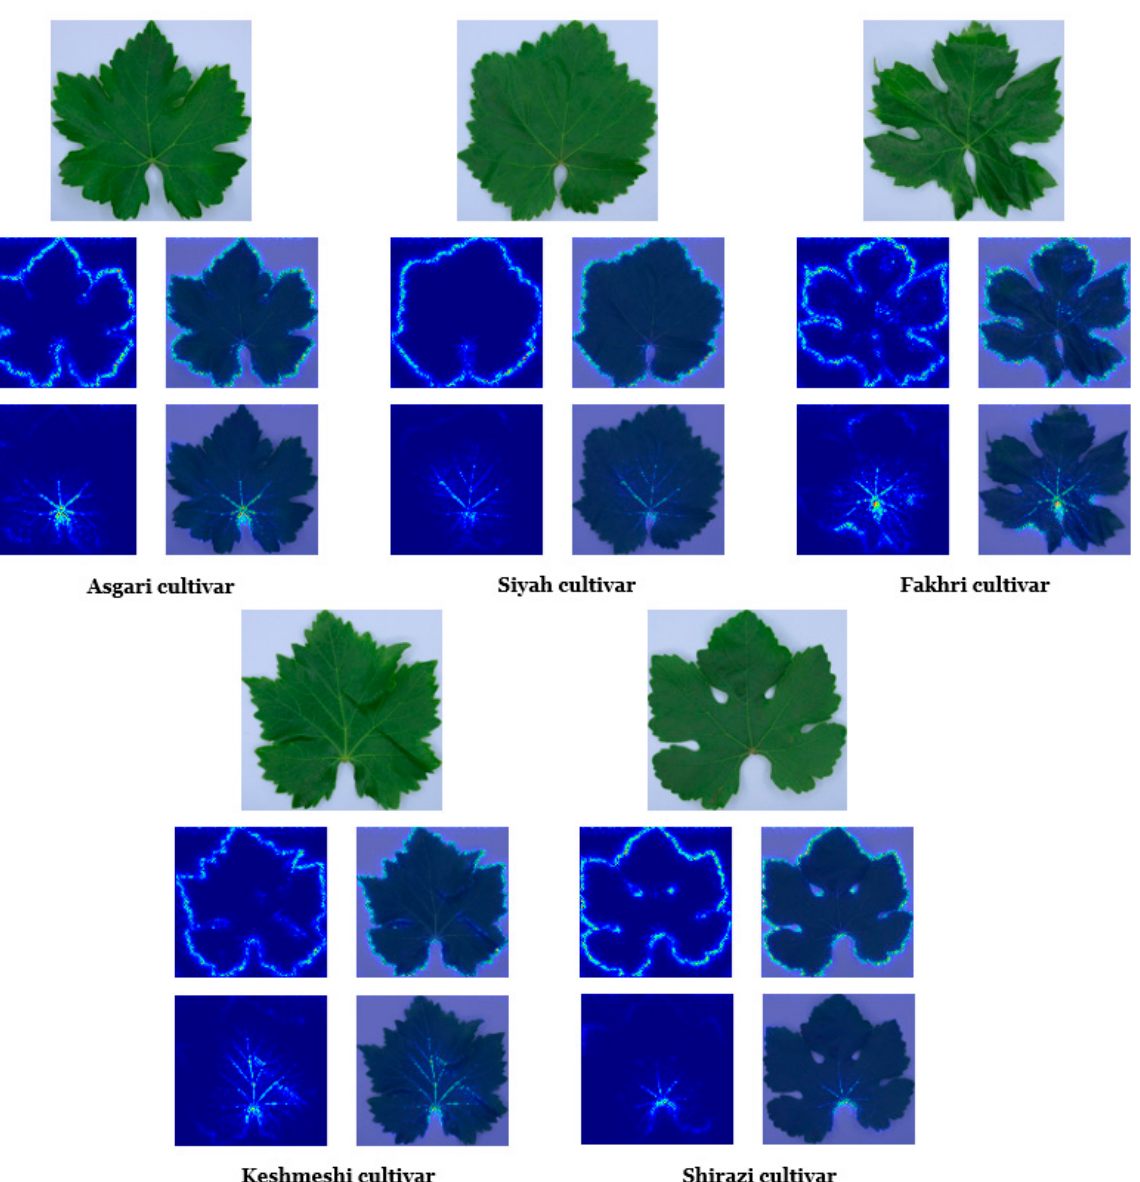
Figure 8. The four picture panel depicts the class saliency map visualization in five grapevine cultivars.